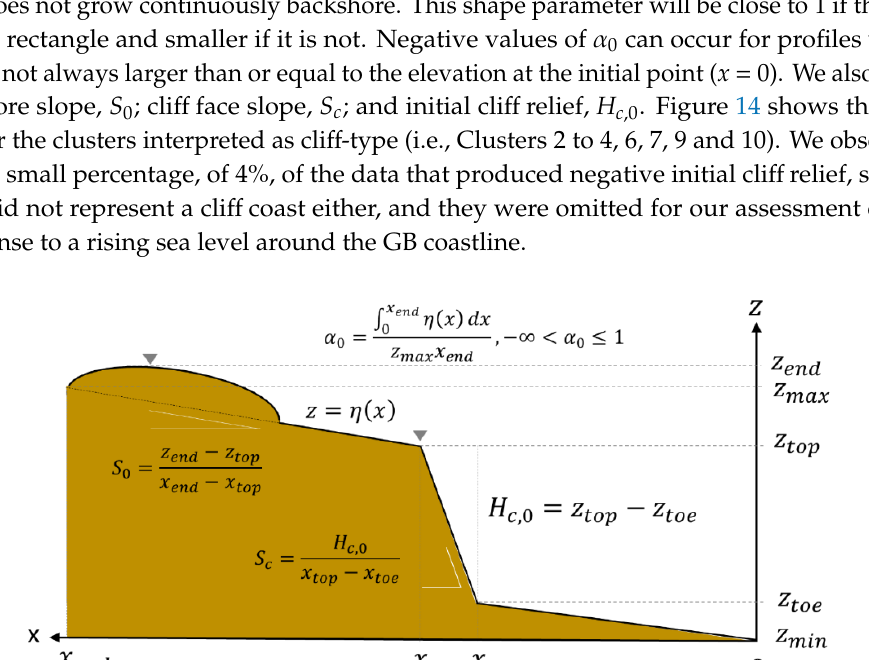
Figure 13. Main geometrical attributes extracted from the elevation profiles along the GB coastline.